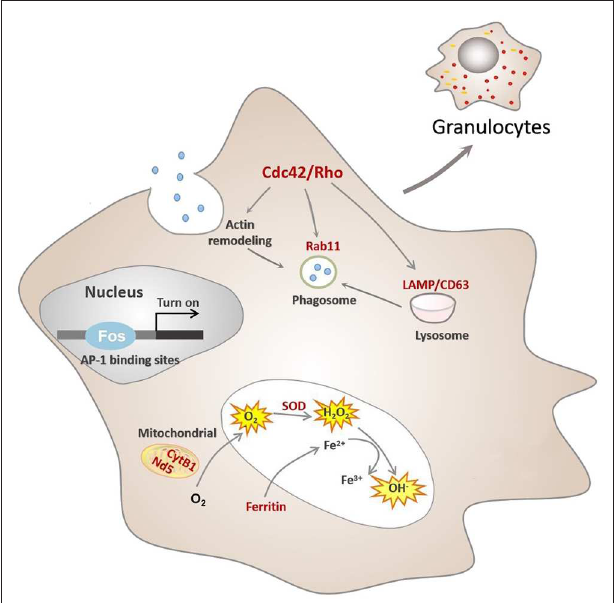
FIGURE 5 | Conceptualization of functional differentiation of hemocytes in C. gigas . During functional differentiation, expression of the transcription factor Fos rises, which turns on transcription by binding to the AP-1 binding site of target genes, marked in red color. These target genes contribute to functional activities of granulocytes, including ROS production and phagocytosis. Cdc42/Cdc42l, the core regulators of granulocytes pathway network, were also transcriptionally controlled by Fos to promote actin rearrangement during phagosome formation in granulocytes, ultimately facilitating